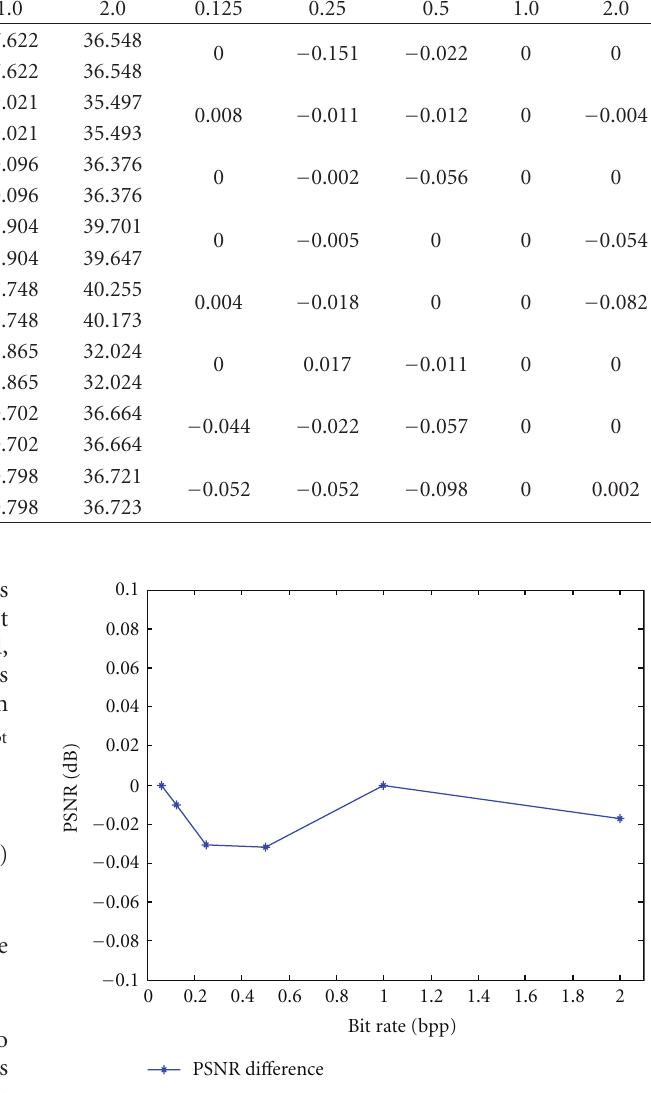
Table 1: PSNR comparison of the proposed algorithm and the PCRD algorithm. Test image